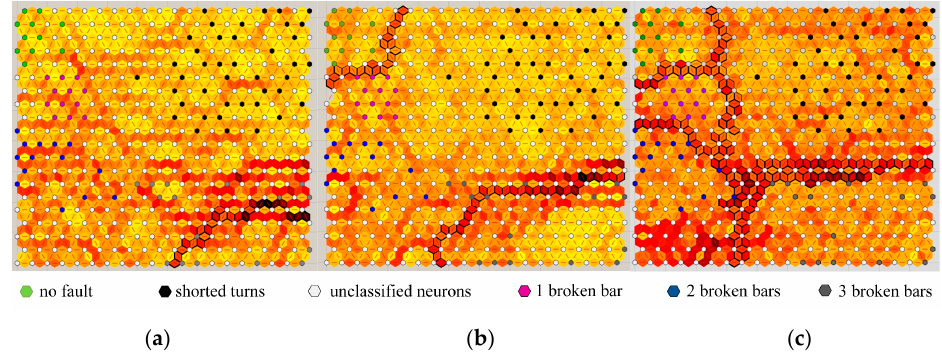
Figure 10. Influence of the number of training epochs and the learning rate to the SOM neighborhood distances: ( a ) 800 training epochs, η = 0.1; ( b ) 300 training epochs, η = 0.7; ( c ) 800 training epochs, η = 0.7.